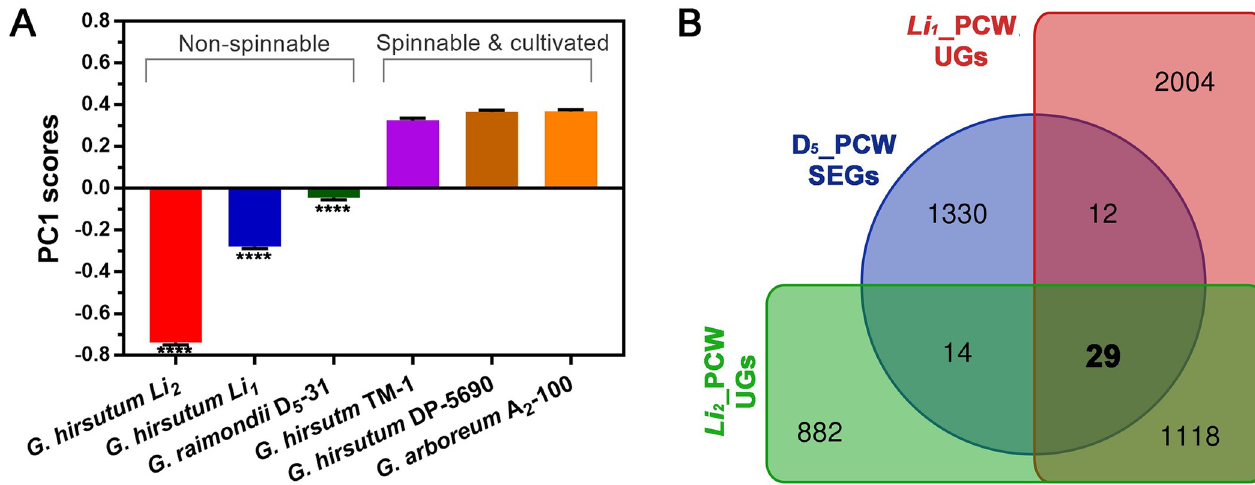
Fig 8. Integrations of chemical phenotypes and transcriptomic profiles between the two sets of cotton materials differing in fiber lengths and cellulose content. A. Classification of the six cotton samples from the first principal component (PC1) scores of principal component analysis operation on normalized ATR FT-IR spectra. B. Venn diagrams comparing the G . raimondii specifically expressed genes (SEGs) at PCW stage with the G . hirsutum Li 1 and Li 2 up- regulated genes (UGs) at PCW stage. The error bars represent standard deviation. ���� p value < 0.0001.